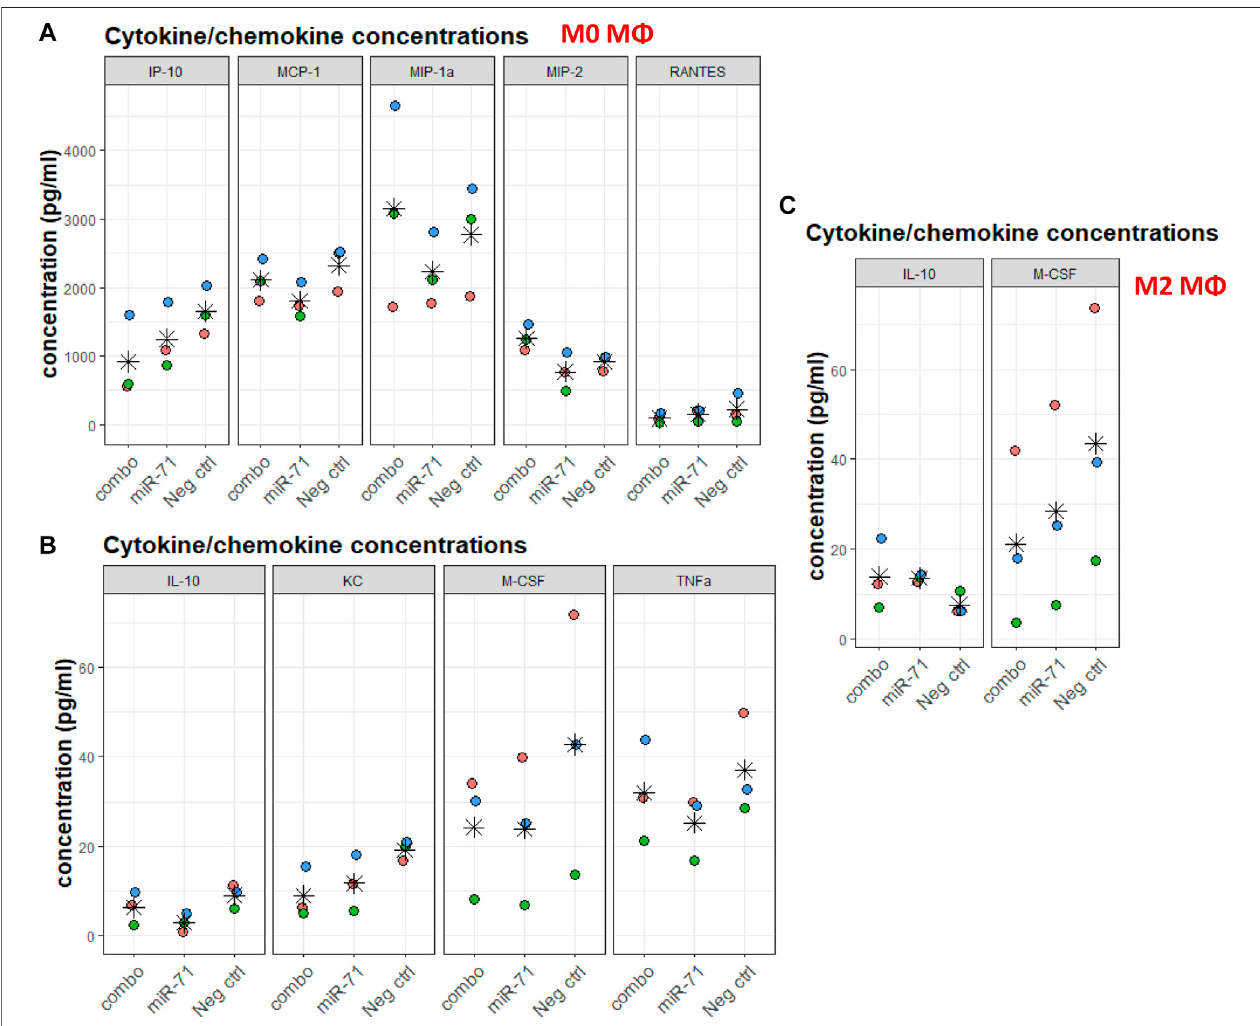
FIGURE 5 | Cytokine/chemokine concentrations in supernatants of macrophages exposed to nematode miRNAs. For each analyte, colors indicate replicates, stars indicate the mean across three data points. (A,B) Chemokine/cytokine concentration (in pg/ml) varying upon miRNA transfection of M0 macrophages. (C) Chemokine/cytokineconcentration(inpg/ml)varyinguponmiRNAtransfectionandpolarizationtowardthealternativeactivationpro fi leM2.IP-10:IFN- γ -inducedprotein 10 (Cxcl10); MCP-1: monocyte chemoattractant protein 1 (CCl2); MIP-1a: macrophage inhibitory protein 1a; MIP-2: macrophage inhibitory protein 2; RANTES: regulated upon activation, normal T cell expressed and presumably secreted (CCl5); IL-10: interleukin 10; KC: keratinocytes-derived chemokine (CxCl1); M-CSF: macrophage colony-stimulating factor (Csf1); TNF- α : tumor necrosis factor 1 α . All concentrations were within range of detection 3.2 – 10,000 pg/ml (and 12.8 – 40,000 pg/ml for IL-13). Statistical signi fi cance of variation across conditions was performed against Neg. ctrl (UNC) using the Dunnett ’ s test.